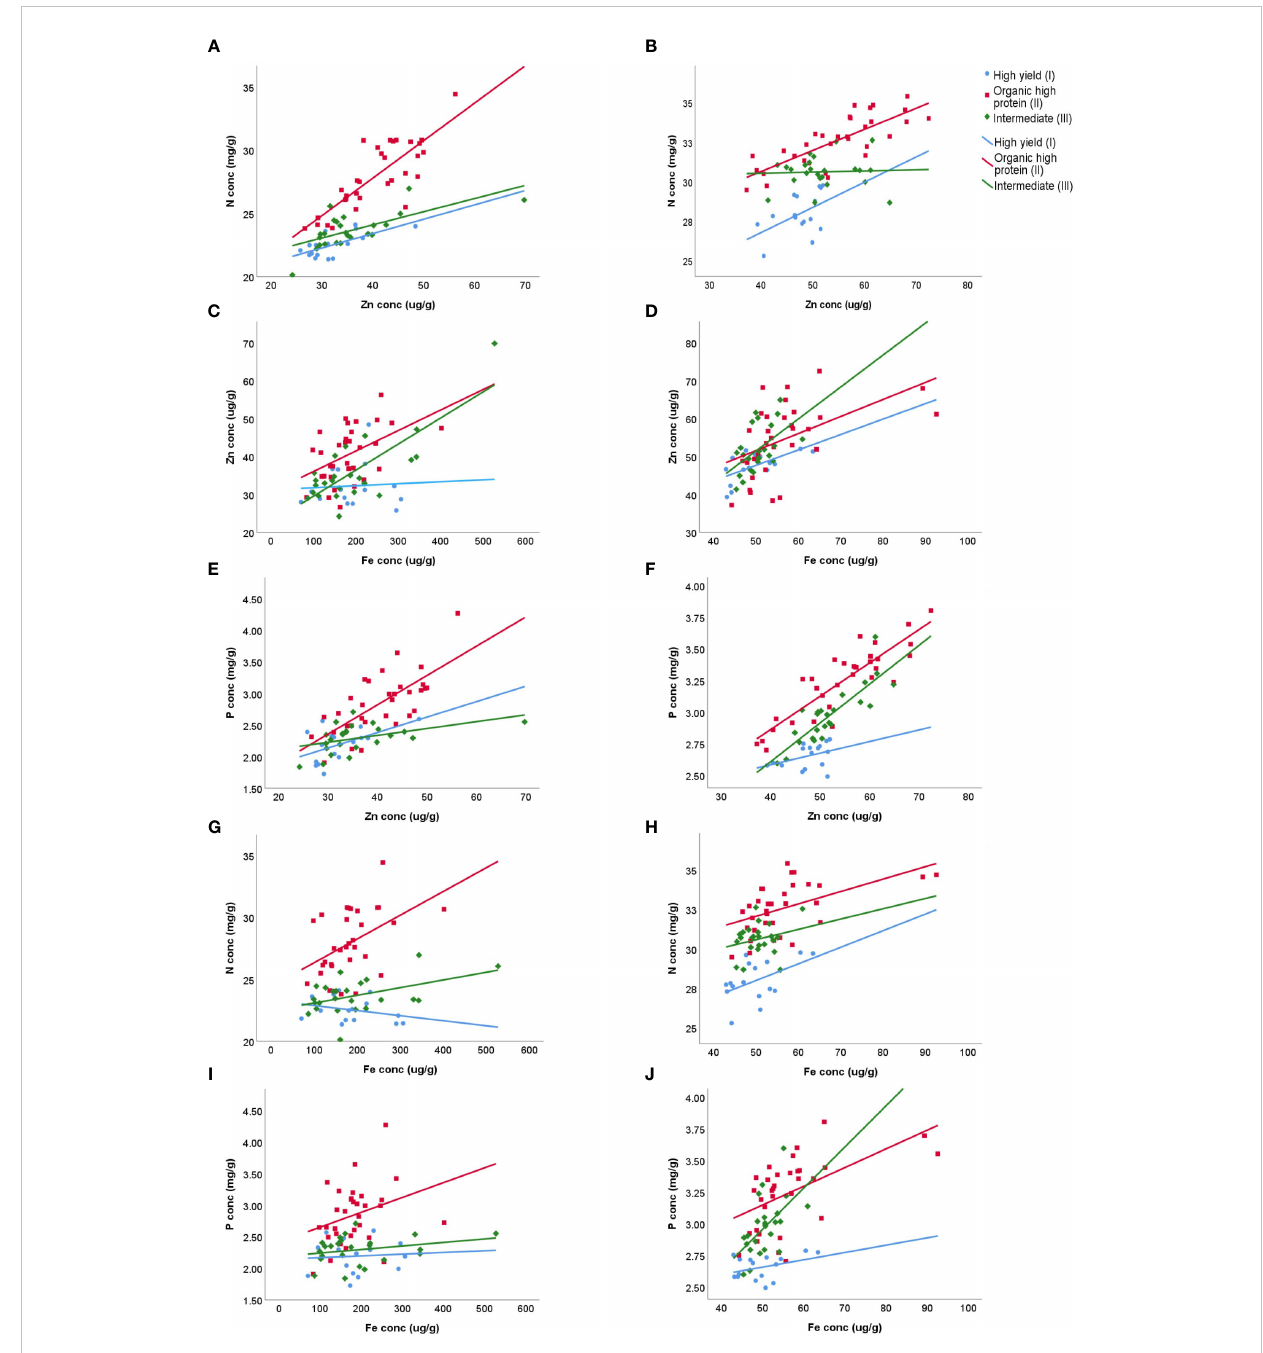
FIGURE 3 Relationships between grain concentrations of various macro- and micro-elements relevant for bioforti fi cation potential, plotted for 2018 and 2019 data sets and grouped into three wheat types (of nine spring wheats) grown in Uppsala, Sweden. Shown are the relationships between N and Zn concentrations: (A) 2018 and (B) 2019, Zn and Fe concentrations (C) 2018 and (D) 2019, Zn and P concentrations (E) 2018 and (F) 2019, N and Fe concentrations: (G) 2018 and (H) 2019, and P and Fe concentrations: (I) 2018 and (J) 2019Linear regressions: (A) High yield R 2 = 0.467, Organic high protein R 2 = 0.663, Intermediate R 2 = 0.451; (B) High yield R 2 = 0.238, Organic high protein R 2 = 0.614, Intermediate R 2 = 0.002; (C) High yield R 2 = 0.004, Organic high protein R 2 = 0.220, Intermediate R 2 = 0.619; (D) High yield R 2 = 0.385, Organic high protein R 2 = 0.252, Intermediate R 2 = 0.269; (E) High yield R 2 = 0.276, Organic high protein R 2 = 0.495, Intermediate R 2 = 0.205; (F) High yield R 2 = 0.148, Organic high protein R 2 = 0.771, Intermediate R 2 = 0.715; (G) High yield R 2 = 0.089, Organic high protein R 2 = 0.209, Intermediate R 2 = 0.211; (H) High yield R 2 = 0.241, Organic high protein R 2 = 0.267, Intermediate R 2 = 0.060; (I) High yield R 2 = 0.005, Organic high protein R 2 = 0.097, Intermediate R 2 = 0.071; (J) High yield R 2 = 0.138, Organic high protein R 2 = 0.304, Intermediate R 2 = 0.306 Traits N conc Nitrogen concentration, Zn conc Zinc concentration, Fe conc Iron concentration and P conc Phosphorus concentration. Wheat varieties High yield wheat type (I) (blue), Organic high protein wheat type (II) (red) and Intermediate wheat type (III)